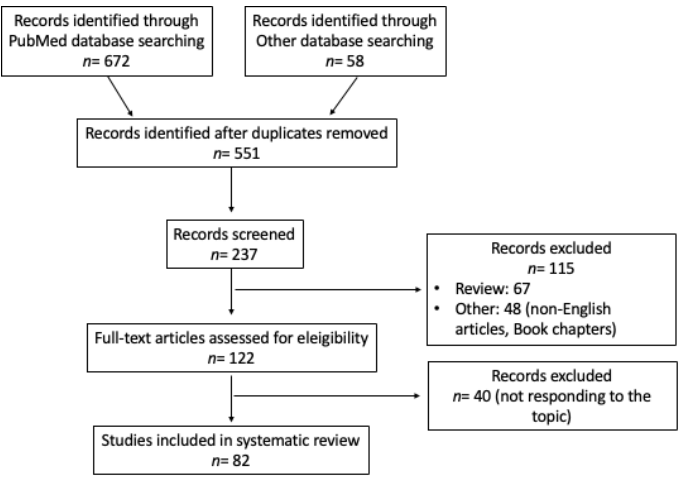
Figure 1. Scheme of record selection according to PRISMA guidelines.